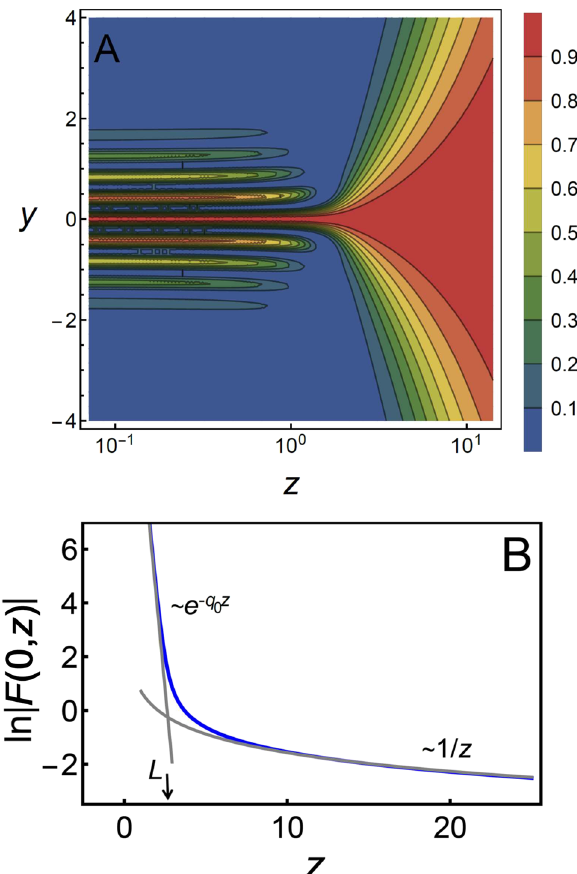
Figure2: Nearfieldofthemodulated-gratingmetasurface;seeEq.(12). (A) Contour plot of the normalized intensity, Re 2 [ F ( y , z )]/Re 2 [ F (0, z )], for q 0 =7and L =2.5.(B)ln | F (0, z ) | versus z (bluecurve).Graycurvesare